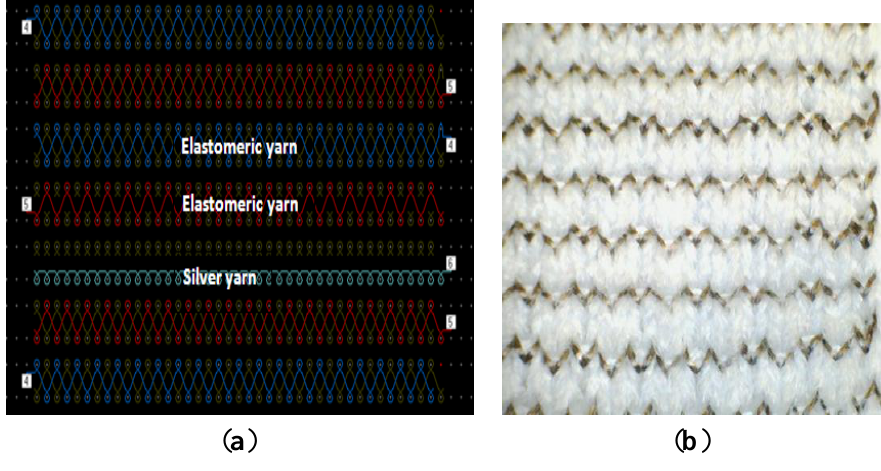
Figure 2. Magnified image of knitted sensor showing a conductive course.